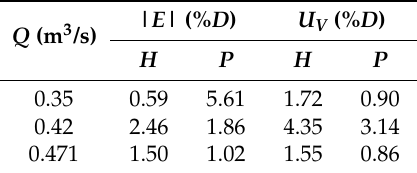
Table 6. The comparison error | E | and validation uncertainty U V at different flow rates.